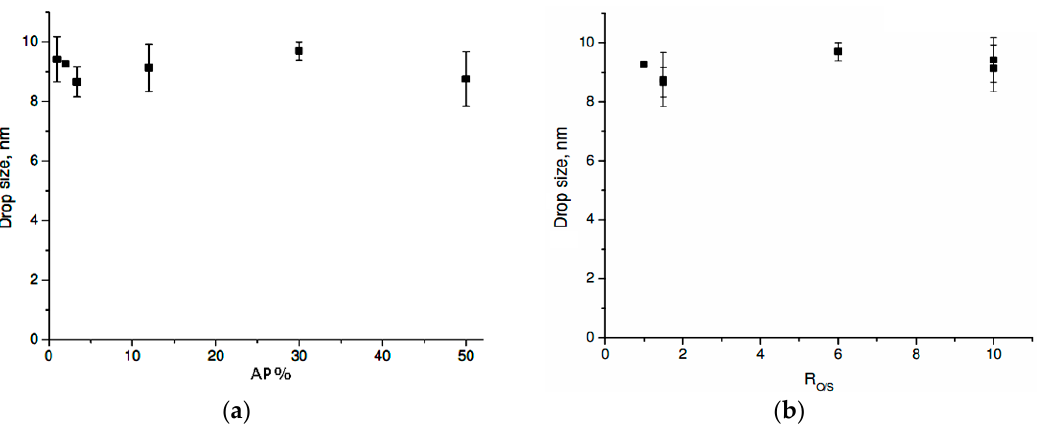
Figure 6. Drop size for the OP//TW80//AP system at T = 25 °C as a function of ( a ) AP % and ( b ) R O/S